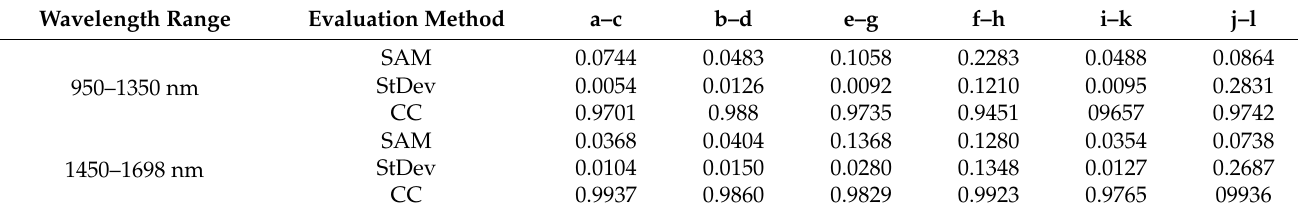
Table 4. Comparison of Spectral Similarity in Near Infrared